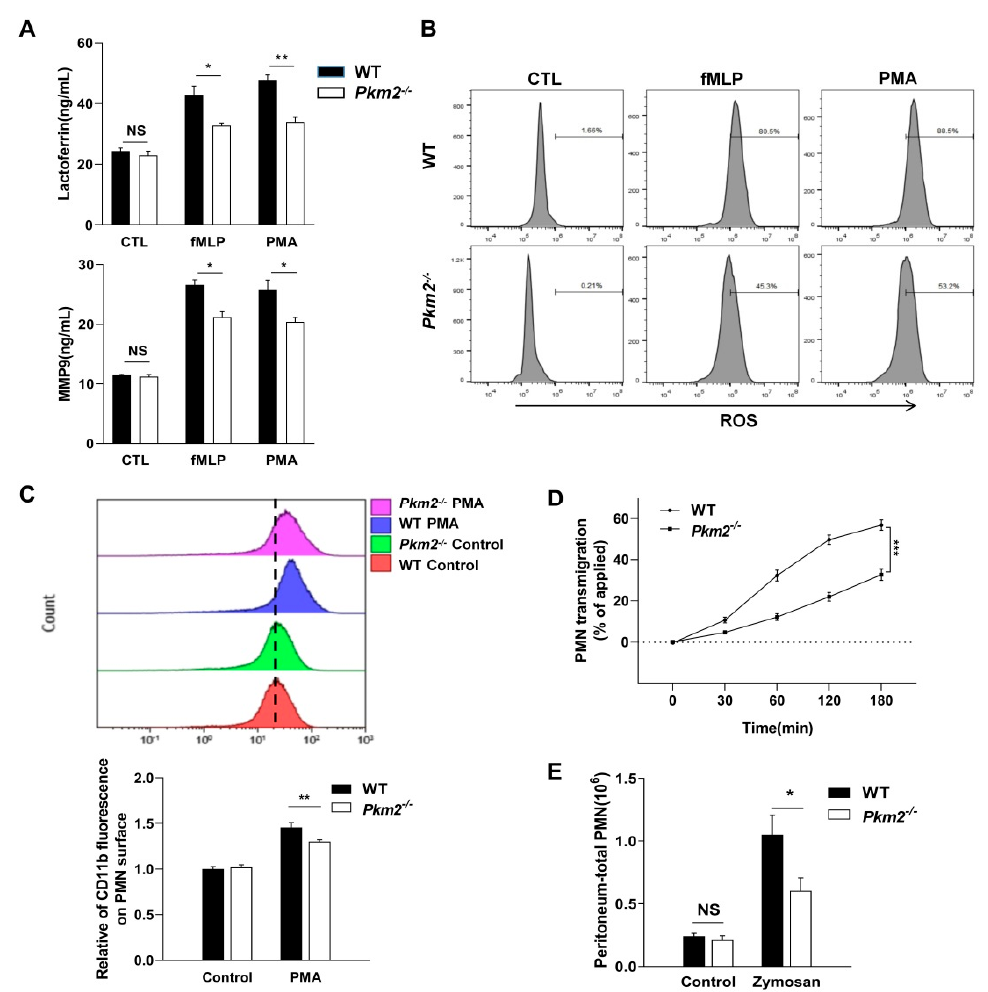
Figure 3. Myeloid-specific Pkm2- deficient mice showed less PMN infiltration. ( A ) Degranulation of secondary and tertiary granules represented by the release of lactoferrin and MMP9 in PMN isolated from WT and Pkm2 -/- , respectively. ( B ) ROS production in neutrophils following fMLP and PMA induction. ( C ) Impaired degranulation of secondary/tertiary granules in PMN isolated from Pkm2 -/- mice with PMA induction. Degranulation of secondary/tertiary granules was detected by measuring the surface CD11b level. ( D ) Impaired fMLP-induced trans-filter migration in PMN isolated from Pkm2 -/- mice as measured by the MPO optical density (OD). ( E ) Impaired zymosan-induced PMN peritoneal infiltration in Pkm2 -/- mice. Data are represented as mean ± SEM. NS, No significance. *, p < 0.05. **, p < 0.01. ***, p < 0.001.